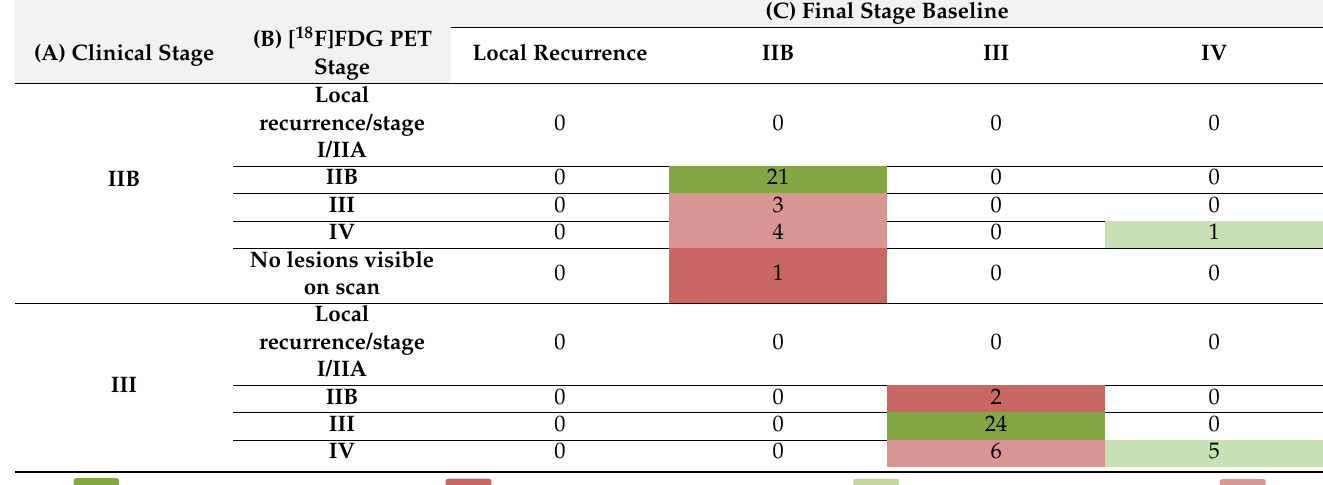
Table 2. Cont. (C) Final Stage